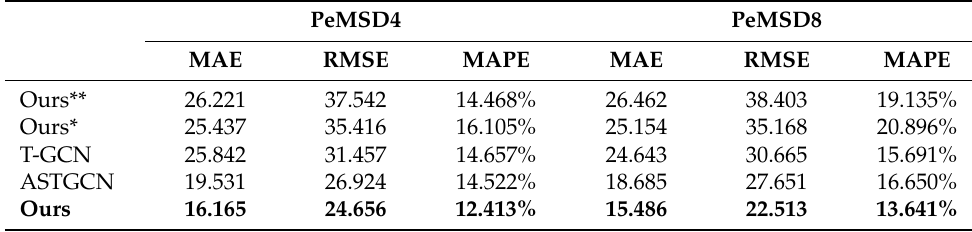
Table 4. Performance comparison for ablation